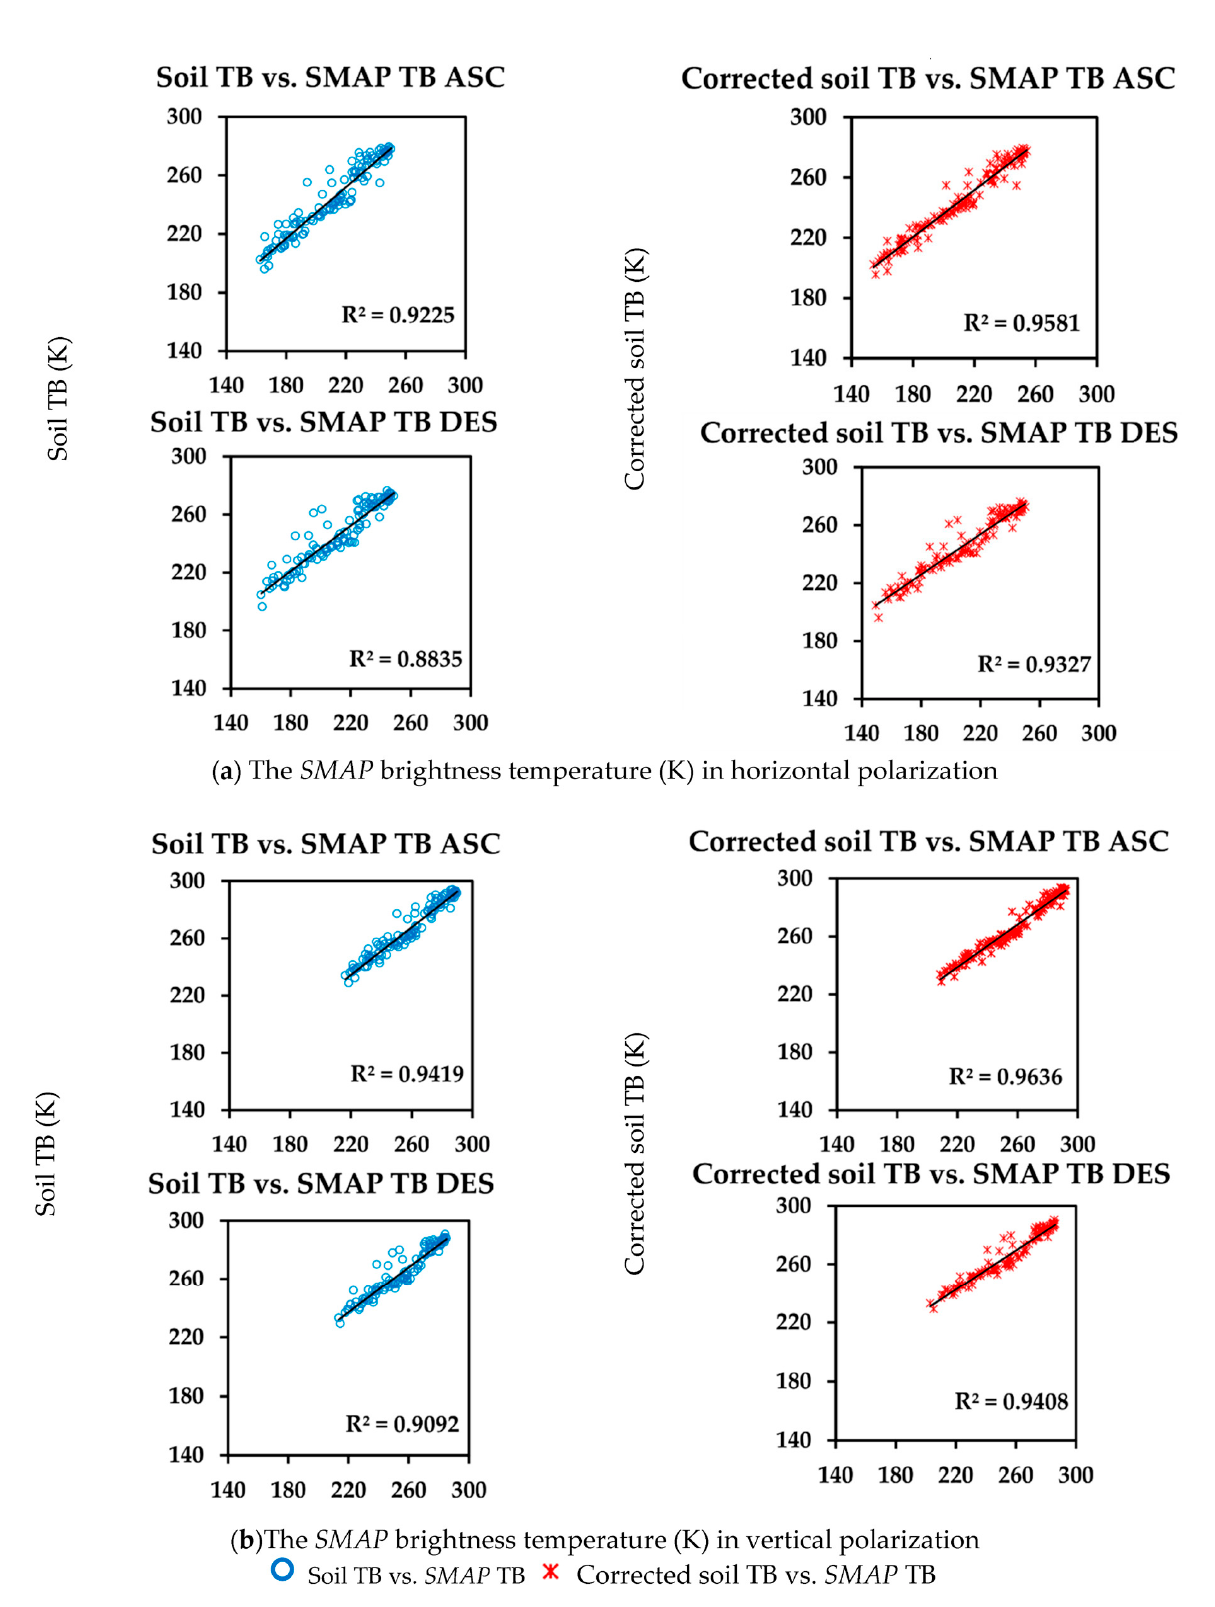
Figure 9. The changes in the correlation between soil TB and SMAP TB of both the ascending and descending nodes before and after correction, at LWREW from September 2017 to December 2019: ( a ) horizontal polarization; ( b ) vertical polarization. The blue dots and red stars stand for the correlation before and after the correction, respectively.